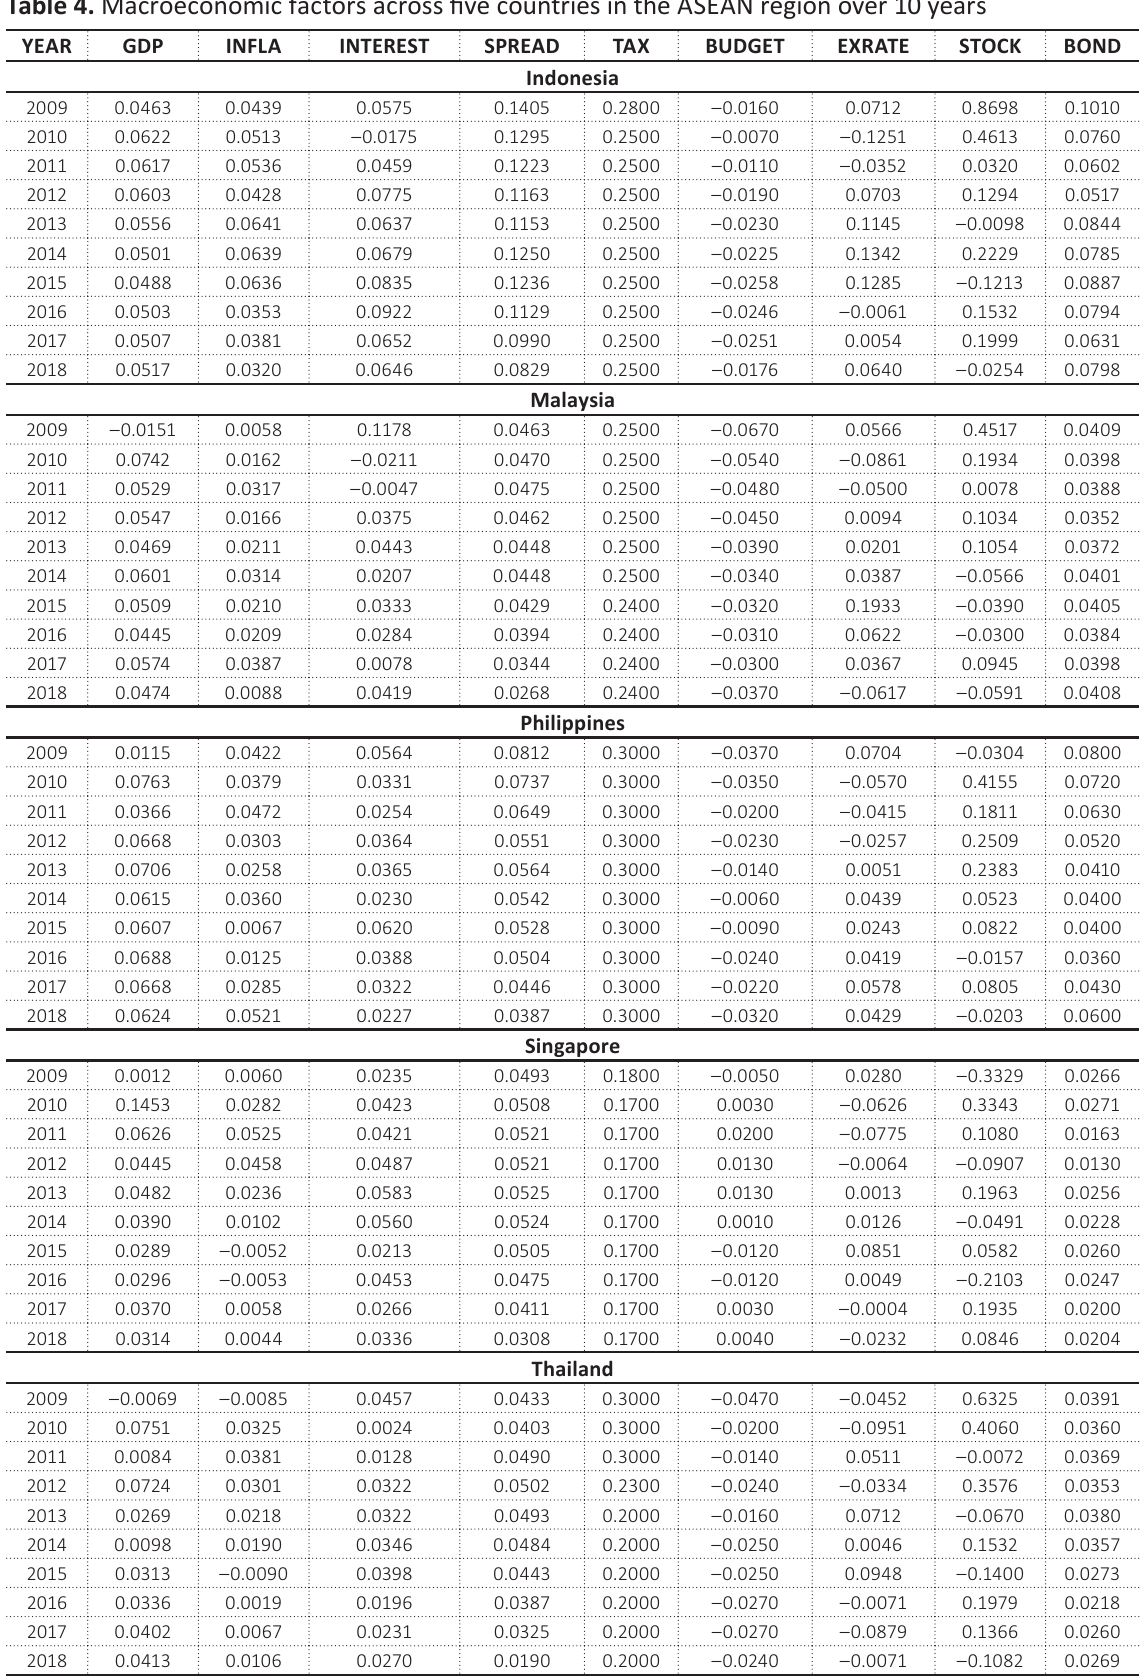
Table 4. Macroeconomic factors across five countries in the ASEAN region over 10